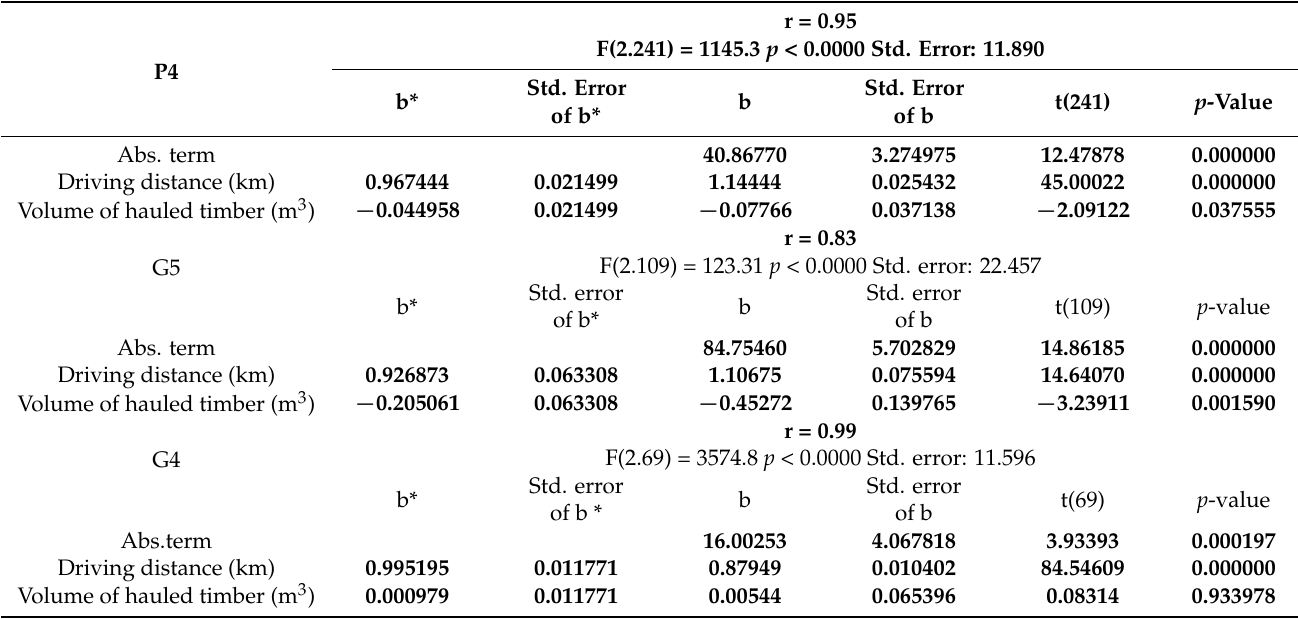
Table 8. Multiple regression and correlation analysis showing relationship between CO 2 (kg) production as a dependent variable and driving distance and volume of hauled timber as an independent